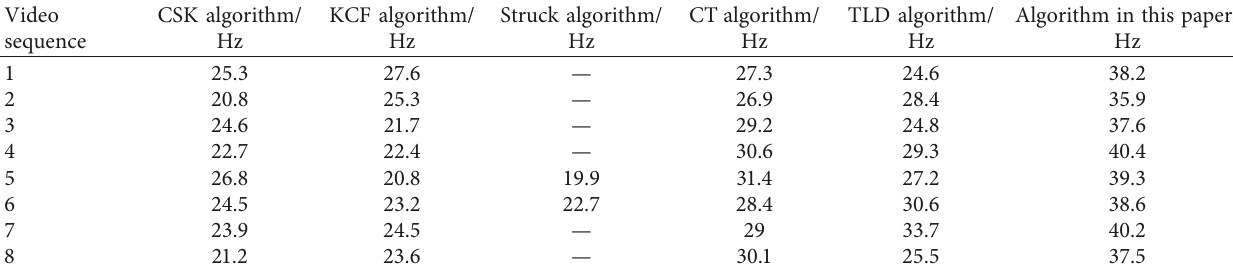
Table 5: Average frame rate comparison results of different algorithms